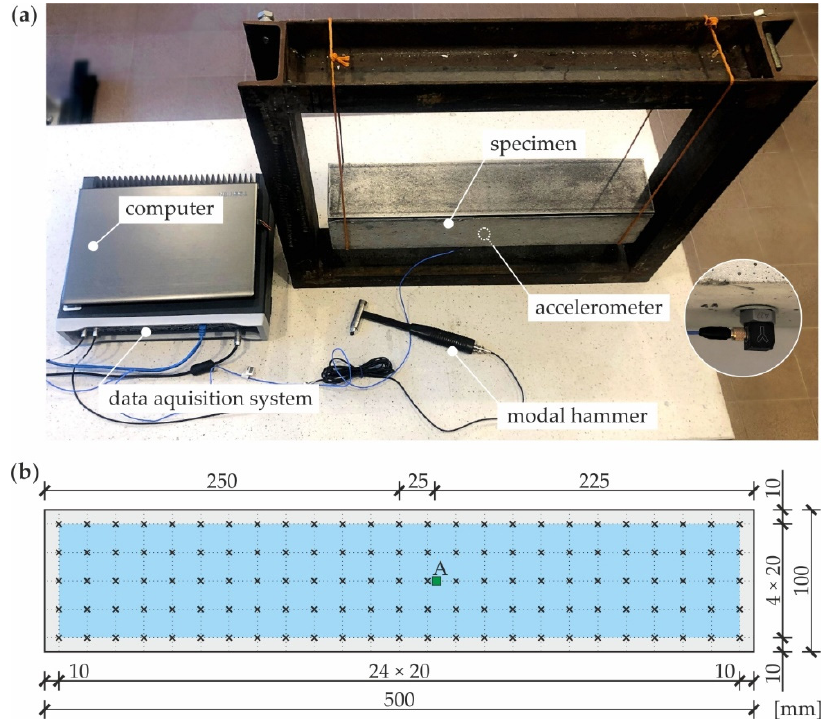
Figure 2. Experimental setup ( a ) and scheme of measurement grid ( b ).